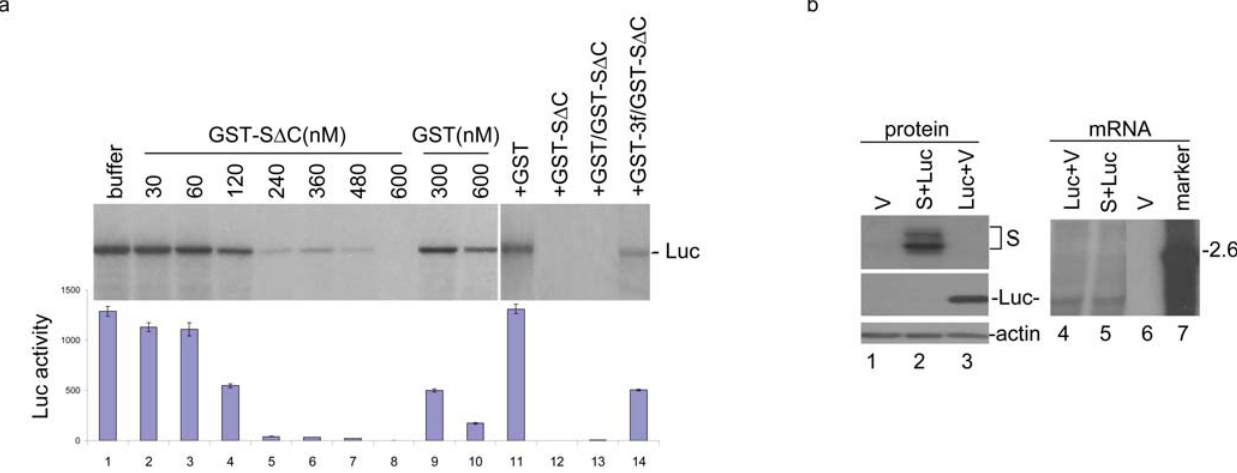
Figure 3. Inhibition of protein synthesis by interaction of SARS-CoV S protein with eIF3f. a. Dose dependent inhibition of luciferase mRNA translation by GST-S D C in vitro (lanes 1–10) and rescue of the inhibition by addition of the purified GST-3f (lanes 11–14). In vitro transcribed luciferase mRNA (0.5 m g) was translated in vitro in rabbit reticulocyte lysates in the presence of [ 35 S] methionine. Glutathione buffer (lane 1), increasing amounts of GST-S D C (lanes 2–8), GST (lanes 9–10), purified GST (lane 11), GST-S D C (lane 12), GST + GST-S D C (lane 13), or GST-S D C + GST-3f (lane 14) were added to the translation system as indicated. Polypeptides were separated on SDS-10% polyacrylamide gel and visualized by autoradiography (upper panels). A duplicate of the in vitro translation reactions in the absence of [ 35 S] methionine (replaced by cold-methionine) was used to measure the luciferase activity (lower graph). b. Inhibition of luciferase translation by the full-length SARS-CoV S protein in intact cells. HeLa cells on 6-well plates were infected in duplicate with the recombinant vaccinia virus vTF7-3, and transfected with 1.2 m g of empty vector pKT0 (V) (lanes 1 and 6), 1 m g pKT0/S + 0.2 m g pLUC (lanes 2 and 5), and 1 m g pKT0 + 0.2 m g pLUC (lanes 3 and 4), respectively. Cells were harvested at 24 hours post-transfection, and protein expression was analyzed by Western blot with anti-luciferase and anti-S antibodies. The same membrane was also probed with anti-actin antibodies as a loading control. The luciferase gene expression at the mRNA level in the transfected cells was also analyzed by Northern blot with a Dig-labeled DNA probe corresponding to the 5 9 -end 550 nucleotides of the luciferase gene (lanes